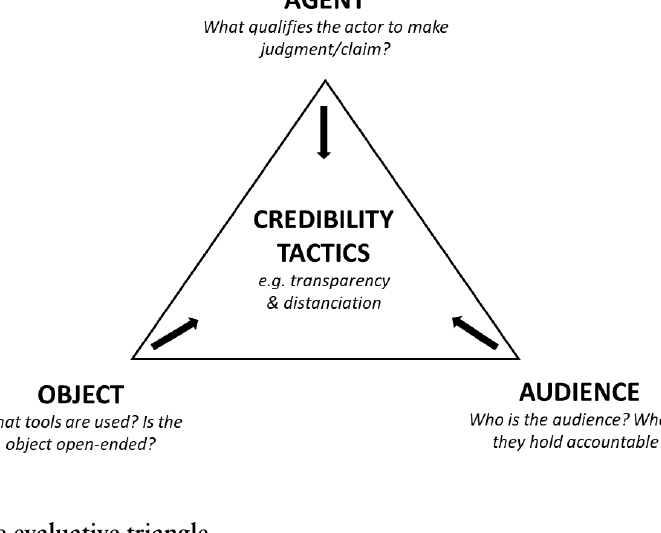
Figure 1 The evaluative triangle Source: Authors’